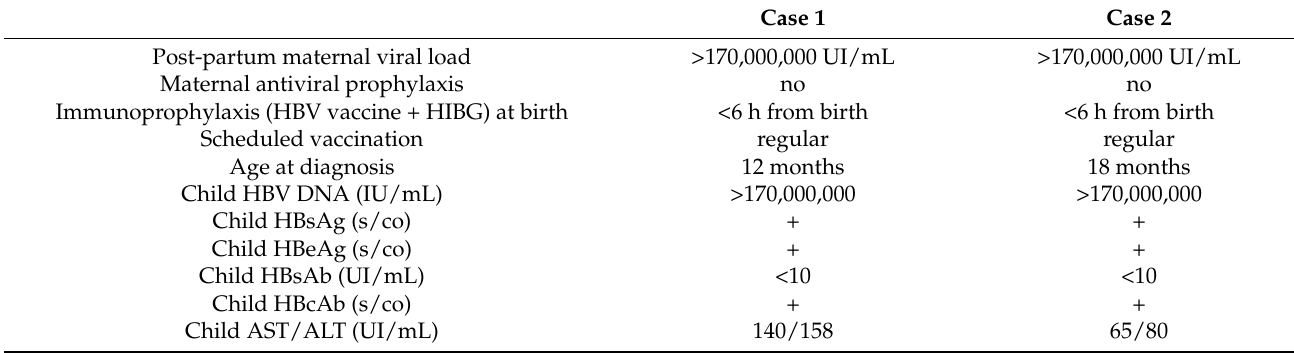
Table 3. Characteristics of two cases of vertical HBV infection. Abbreviations: HBV DNA = hepatitis B virus deoxyribonu- cleic acid; IU = international unit; + = positive; HBsAg = hepatitis B surface antigen; HBeAg = hepatitis B e antigen; HBsAb = antibody to hepatitis B surface antigen; HBcAb = antibody to hepatitis B core antigen; s/co: signal/cut-off; AST = alanine aminotransferase; ALT = aspartate